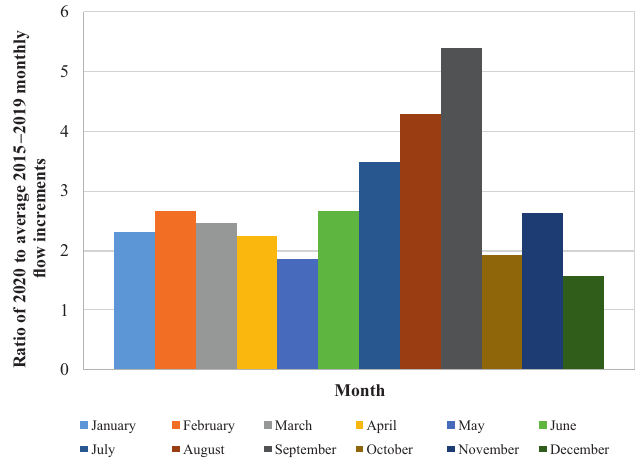
Figure 5. Ratio of year 2020 versus average 2015–2019 monthly flow